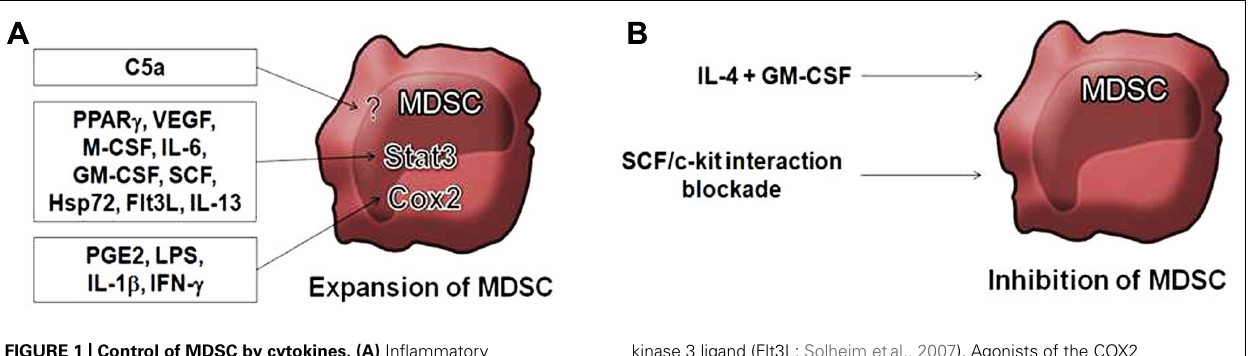
kinase 3 ligand (Flt3L; Solheim etal., 2007). Agonists of the COX2 pathway also result in expansion of MDSC, including prostaglandin E2 (PGE2), lipopolysaccharide (LPS), IL-1 β , and IFN- γ (Obermajer etal., 2011). The complement anaphylatoxin C5a is also described to induce MDSC (Markiewski etal., 2008). (B) Blockade of SCF/c-kit interaction or SCF blockade by siRNA reduce MDSC expansion (Mellstedt etal., 1999). The combination of IL-4 and GM-CSF inhibits MDSC function by inducing their differentiation into mature DC (Bronte etal., 1999; Sinha etal.,